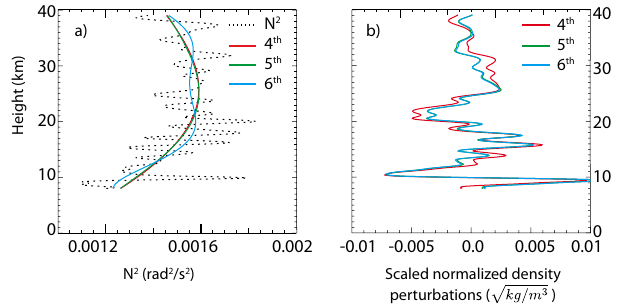
Figure 1. (a) Various (polynomial) fits of the local buoyancy fre- Figure 1. a) Various (polynomial) fits of the local buoyancy frequency squared ( N 2 ( z ) ), b) 6 quency squared ( N 2 (z)) , (b) corresponding scaled normalized den- corresponding scaled normalized density perturbations. 7 sity